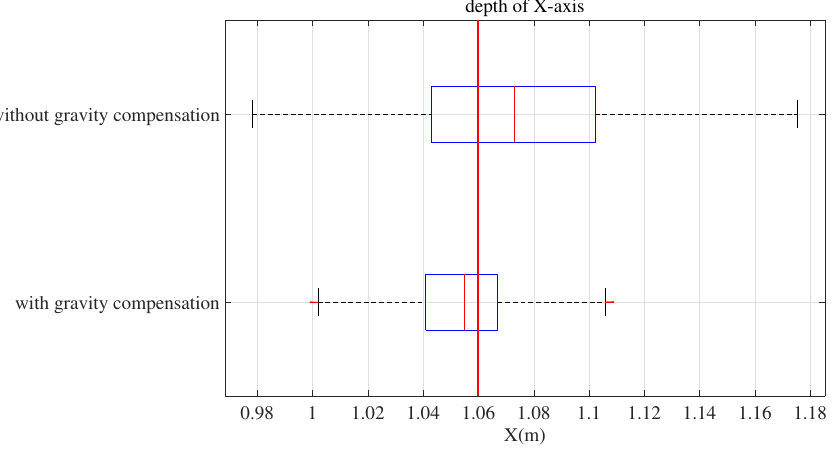
Figure 16. The mean and deviation for depth in the x-axis.